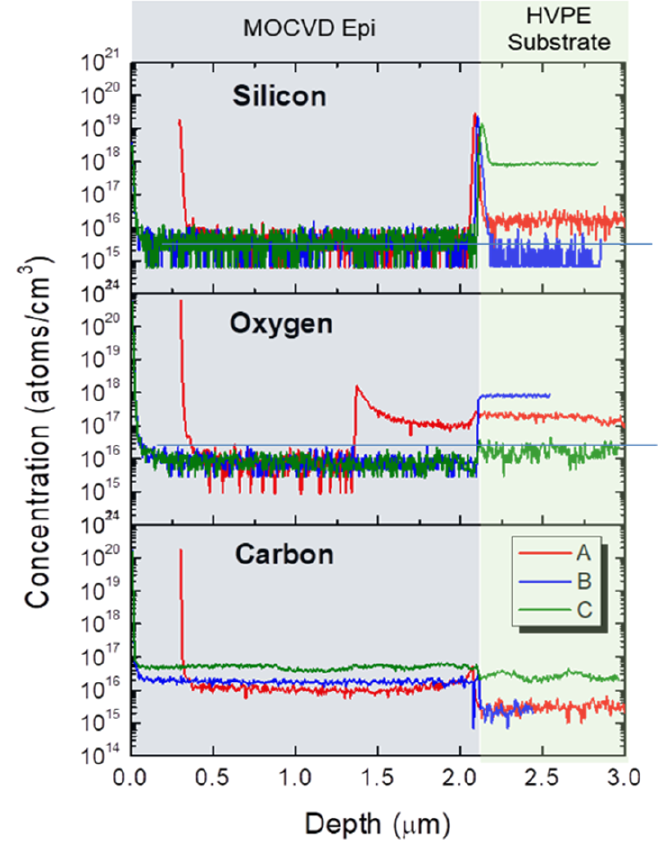
Figure 6. SIMS data from three consecutively grown wafers. The homoepitaxial growth shows no incorporation of C or O at the regrowth interface. Instead, there is a large peak in the Si incorporation at this interface. Reprinted from [20] with permission from Elsevier.